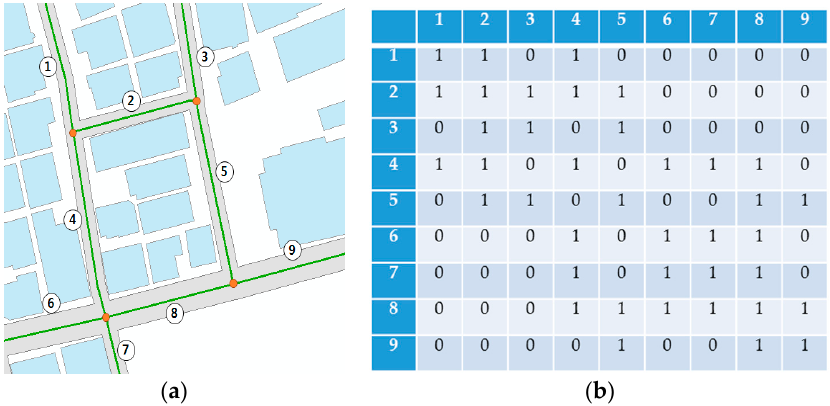
Figure 6. Spatial weight matrix example: ( a ) sample road segments; ( b ) spatial weight matrix of Figure 6a.